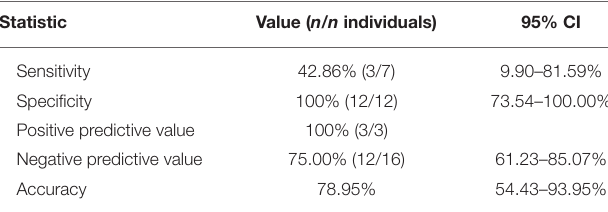
TABLE 3 | Sensitivity and specificity of clinically administered RT-qPCR testing prior to study participation (using anti-n IgG ELISA as the reference